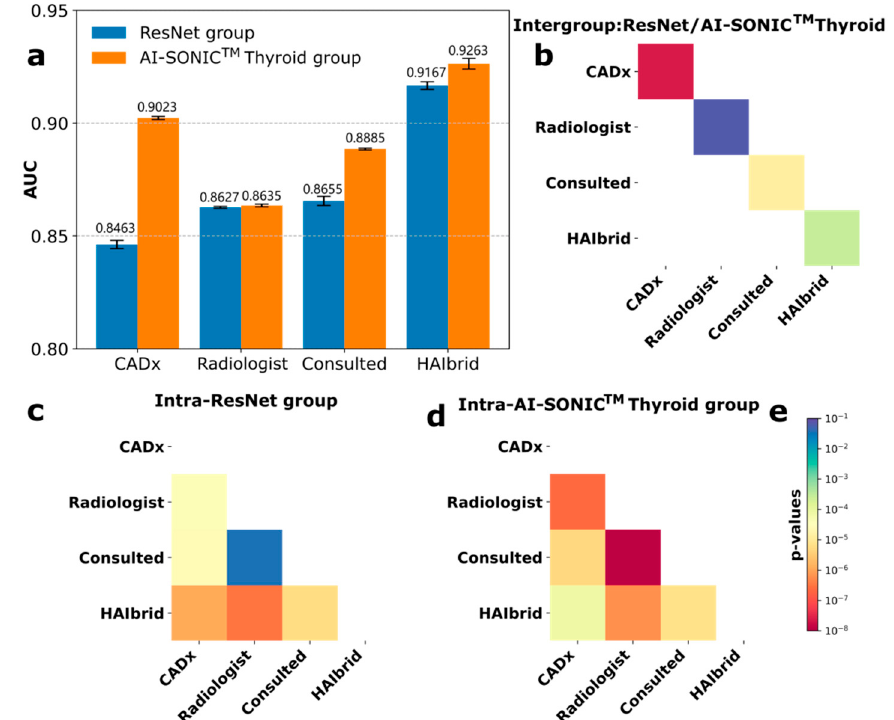
Figure 2. Comparison of two feature-stratified groups of equal sizes (250 cases each) to evaluate the importance of applying GAFM-based HAIbrid approach for improving thyroid nodule diagnosis performances of two CADx systems, the trained ResNet101 and commercial AI-SONIC TM Thyroid.